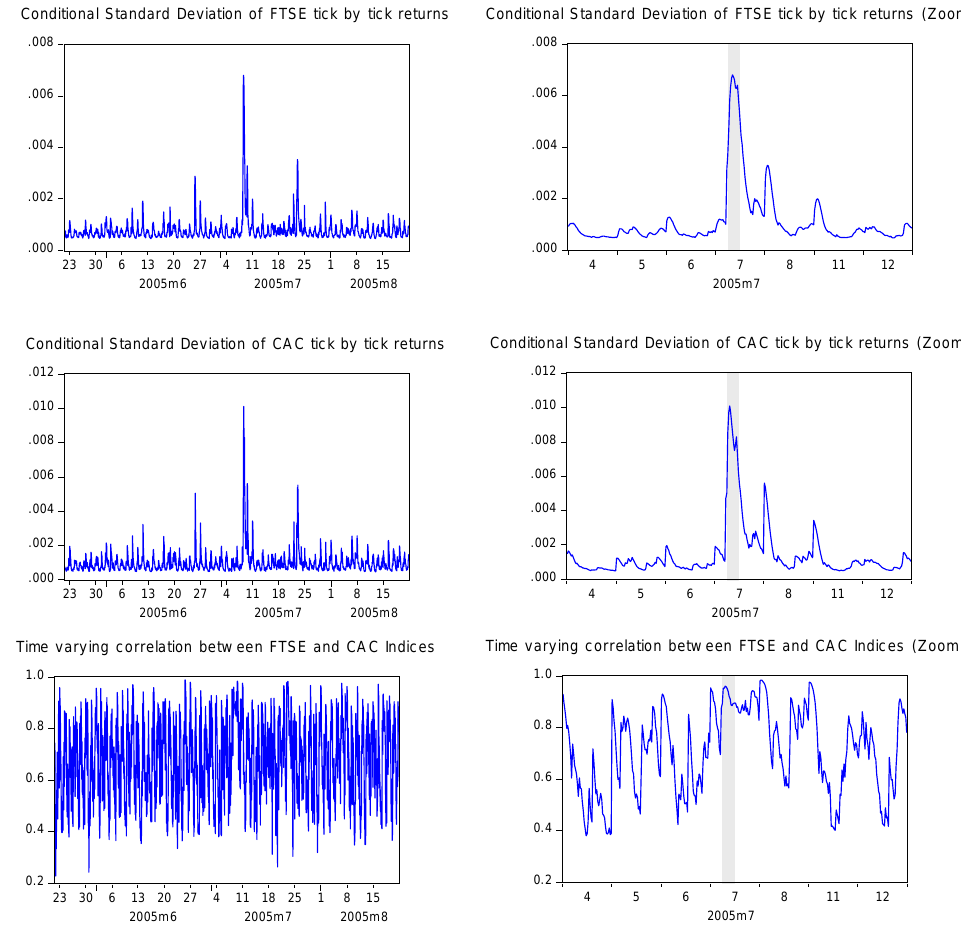
Figure 2. Conditional Volatilities and Correlation for FTSE-CAC intraday stock